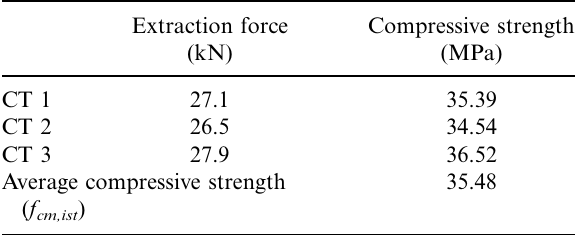
Table 1. ‘Pull-out’ test results (Capo-Test) for the deck plate